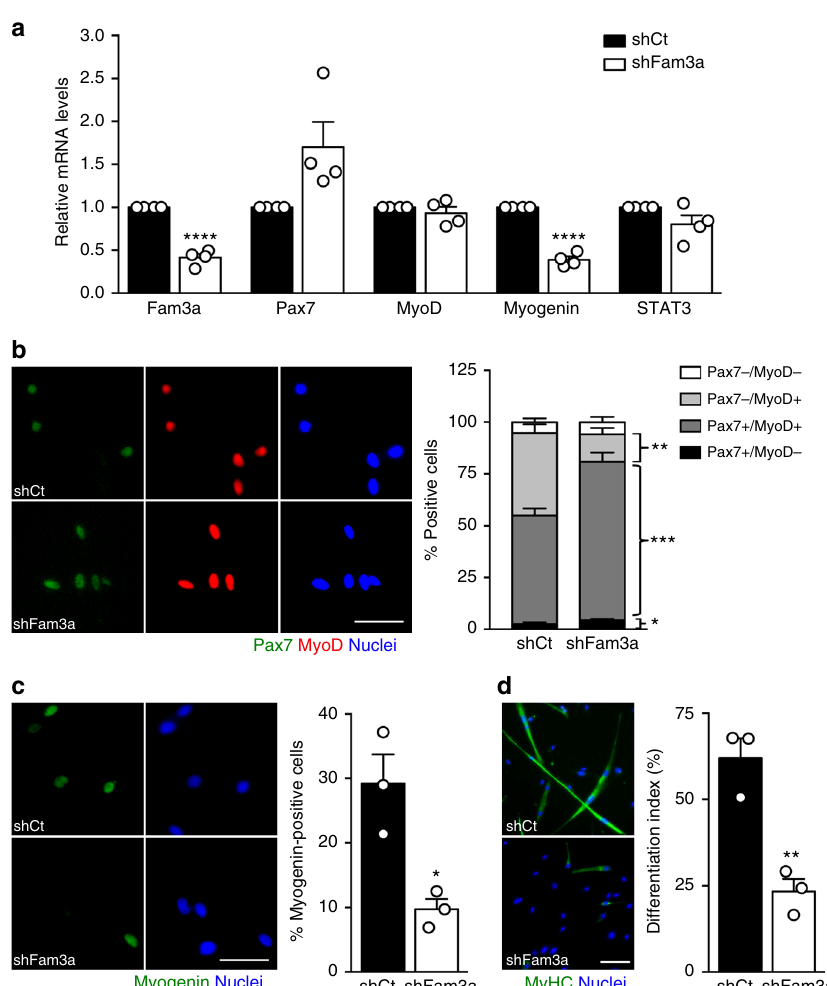
Fig. 3 Fam3a promotes muscle stem cell (MuSC) myogenic lineage progression in vitro. a Gene expression analysis of MuSCs infected with lentiviruses coding for short hairpin RNA (shRNA) Control (shCt) or shRNA against Fam3a (shFam3a) and cultured in growth conditions for 72 h ( n = 4 independent experiments). b , c Immuno fl uorescence analysis and quanti fi cation of myogenic markers of MuSCs infected with shCt or shFam3a coding lentiviruses and cultured in growth conditions for 72 h ( n = 3 independent experiments). Scale bars 50 μ m. d Immuno fl uorescence analysis of myogenic differentiation of MuSCs infected with shCt or shFam3a coding lentiviruses and cultured in differentiation conditions for 72 h ( n = 3 independent experiments). Scale bar 100 μ m. Data are represented as mean ± SEM (Student ’ s t test; * p < 0.05, ** p < 0.01, *** p < 0.001, **** p <